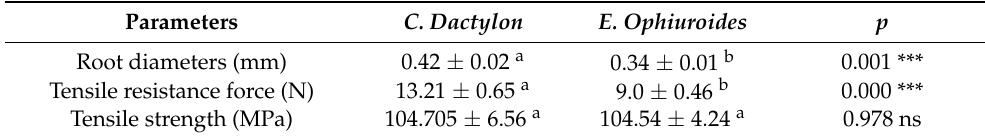
Table 4. Means ± SEs of root diameter, root tensile resistance force and root tensile strength for C. dactylon and E. ophiuroides .